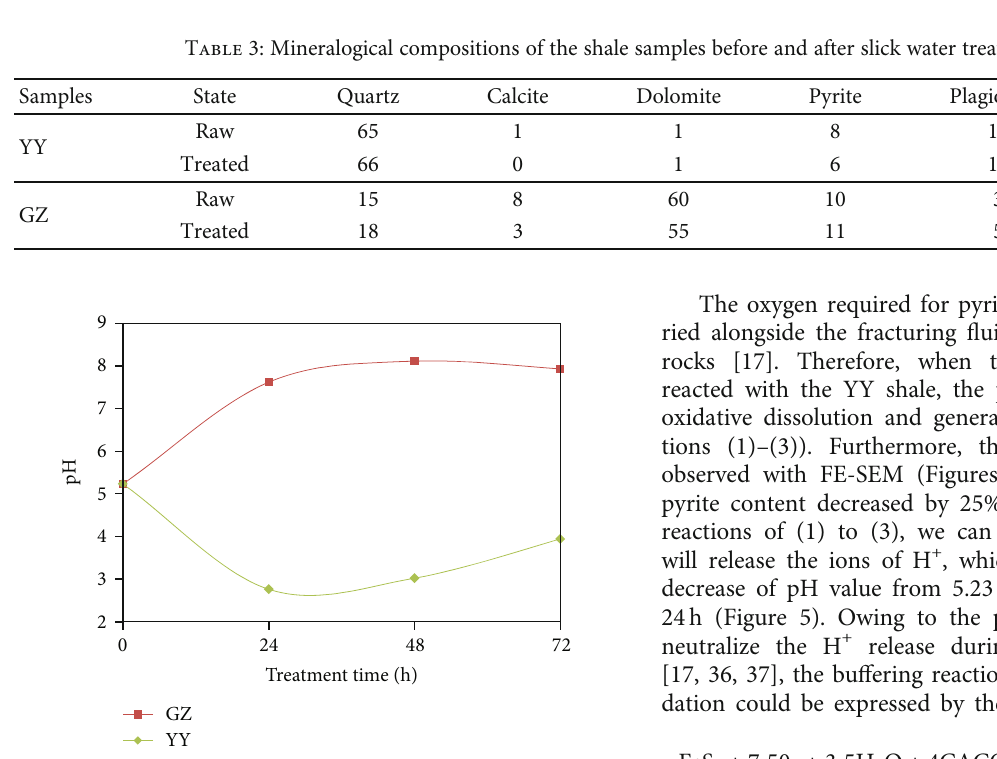
Figure 5: Changes of pH values during the